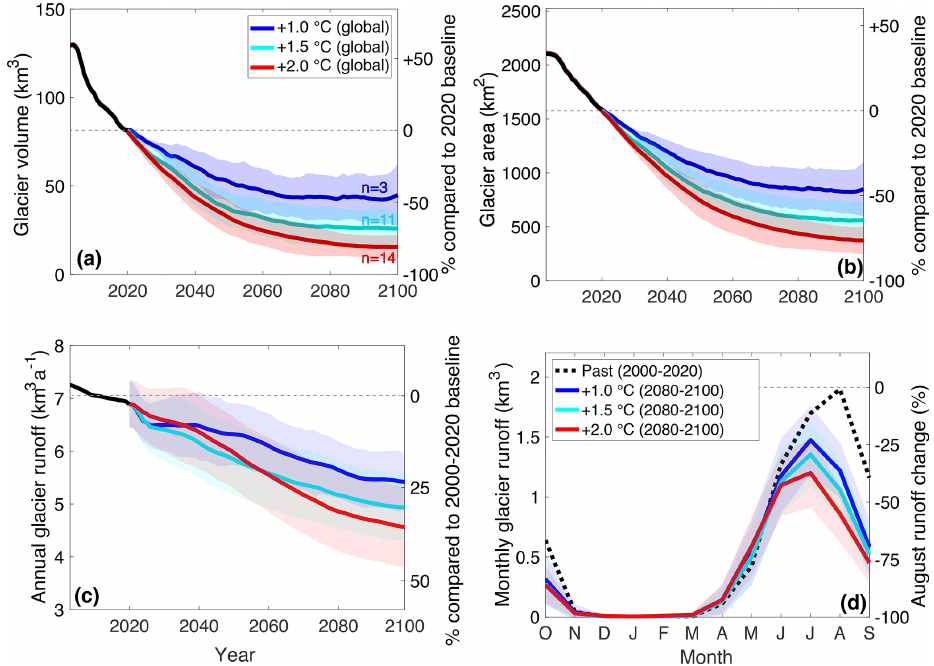
Figure 2. Modelled evolution of total glacier (a) volume, (b) area, (c) annual runoff, and (d) monthly runoff. The total refers to all glaciers of the European Alps. The time series in panel (c) are smoothed with a 30-year running mean. In all panels, the thick line represents the mean, and the transparent band corresponds to 1 standard deviation of the results obtained by forcing GloGEMflow with the selected GCM members. The number of GCM members is given ( n ) in panel (a)